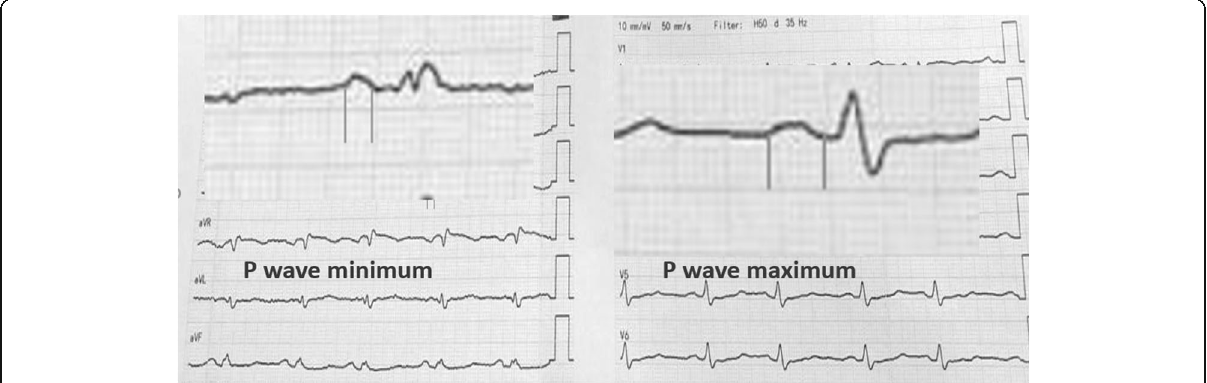
Fig. 1 12 leads ECG in patient with secundum ASD showed P wave duration (Pmax, P min)